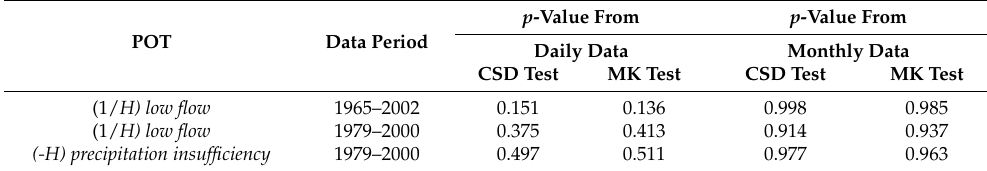
Table 5. Statistical results on the analysis of trend direction.